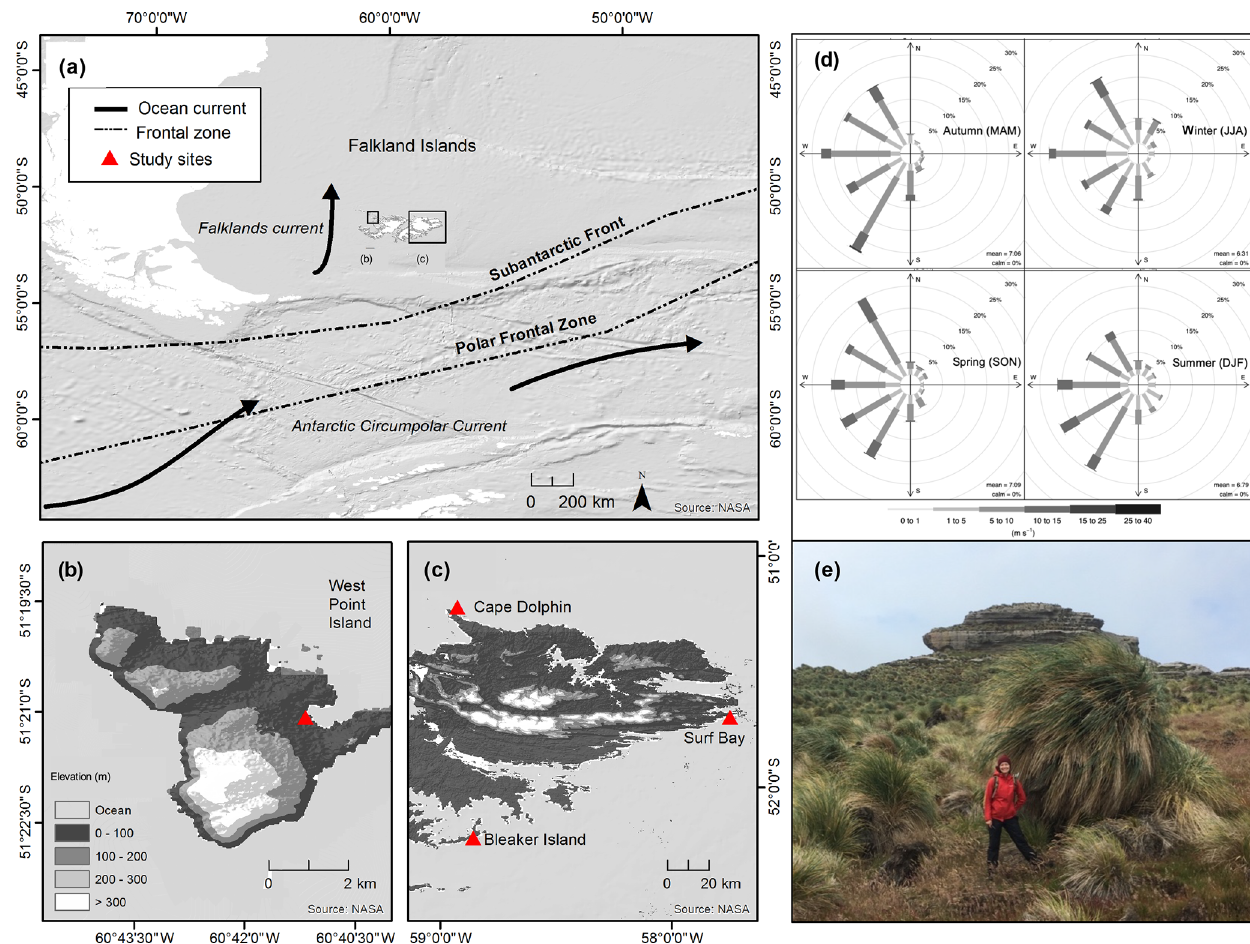
Figure 1. Study region. (a) Map of the Falkland Islands and western South Atlantic Ocean with ocean currents (black arrows) and frontal zones (dashed lines). Study sites are shown for (b) West Point Island and (c) Bleaker Island, Cape Dolphin, and Surf Bay. (d) Distribution of wind speed (ms − 1 ) and the frequency of counts by wind direction (%) at Bleaker Island across four seasons, autumn (MAM), winter (JJA), spring (SON), and summer (DJF), along with mean seasonal wind speed (ms − 1 ) and % calm. Measurements logged at 15min intervals using Bleaker Island weather station (MetPak II) from September 2015 to August 2016. The wind rose was constructed using the package openair in R version 3.1.0. (e) A single large Poa flabellata pedestal made up of dead and living grass tillers growing on top of a decomposing pedestal at Cape Meredith, West Falkland, Falkland